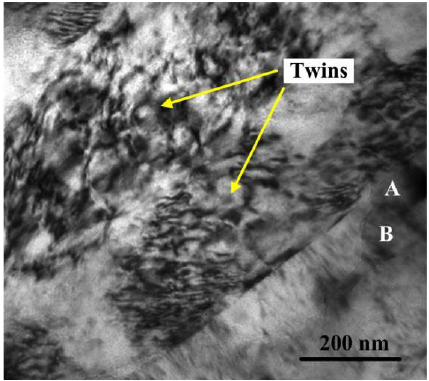
Figure 8. The TEM bright field image of the newly-generated grains through DRX.